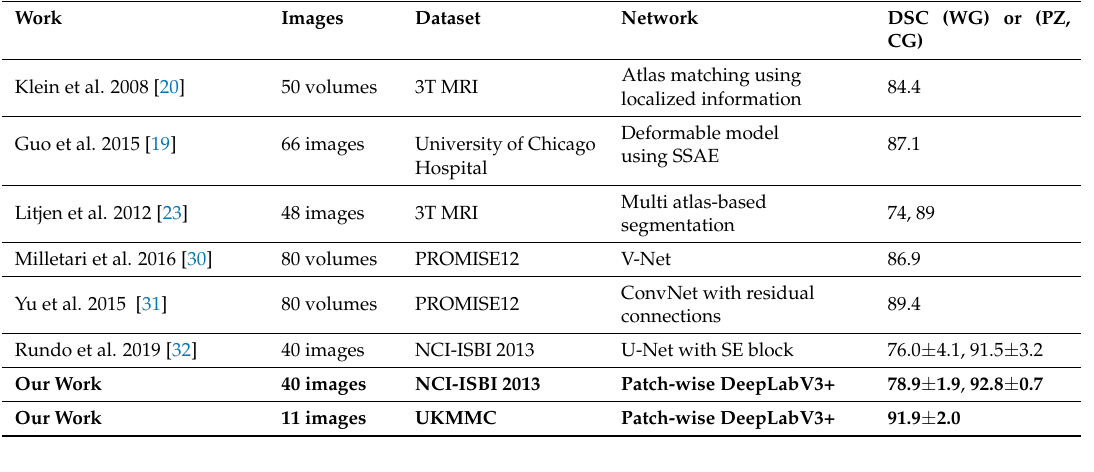
Table 4. Comparison of DSC values (in percentage) of atlas-based, deformable model-based, CNN-based, and our patch-wise DeepLabV3+.